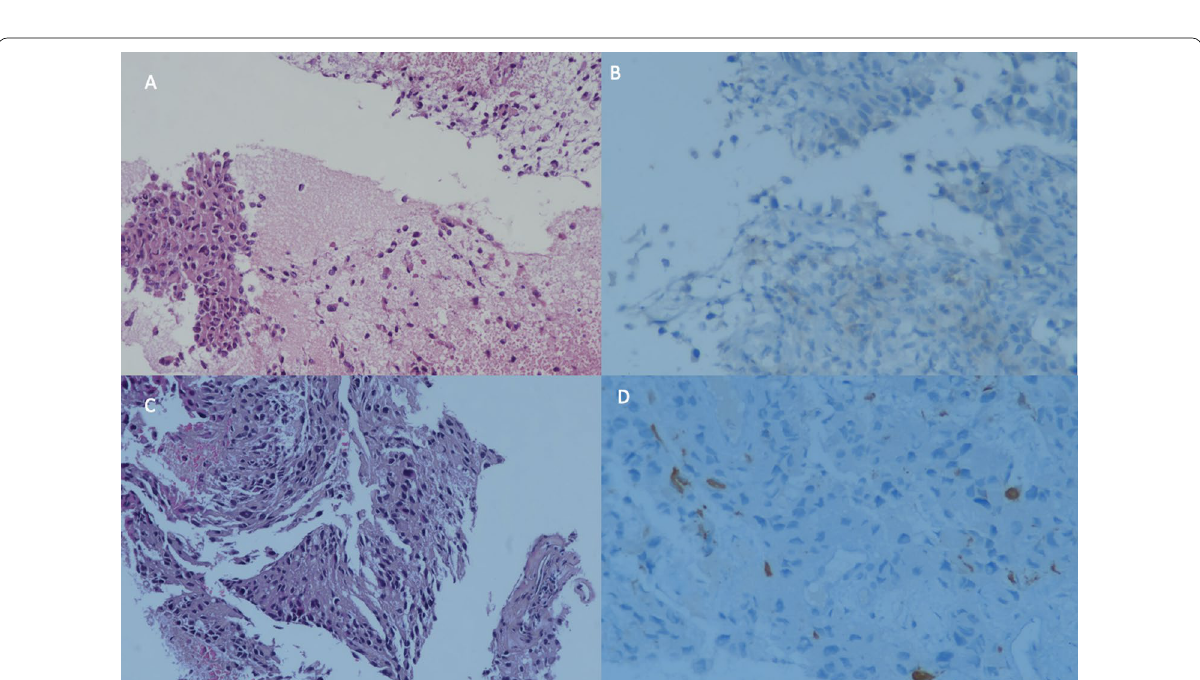
Fig. 6 Subcutaneous soft tissue biopsy. A Tumor cells in liquid-based cytology cell block (H&E*100). B . GFAP positivity in tumor cells in liquid-based cytology cell block (IHC*400). C Subcutaneous soft tissue tru-cut biopsy: pleomorphic tumoral infiltration with hyperchromatic nuclei within the fibrous stroma (H&E*100). D . Subcutaneous soft tissue tru-cut biopsy: GFAP circulating positivity